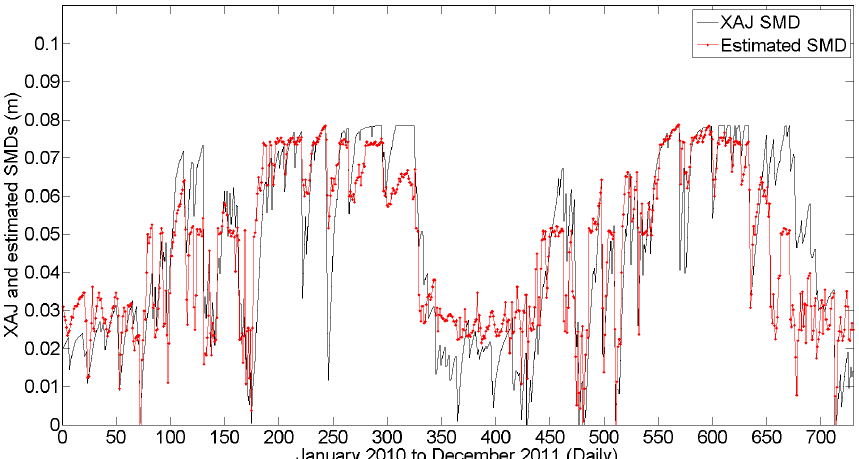
Figure 10. Time series plot of the combined daily hydrological soil moisture state